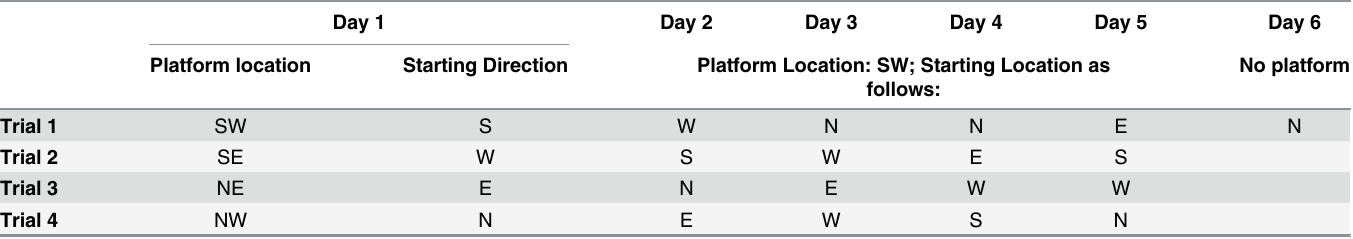
Table 1. Morris Water Maze